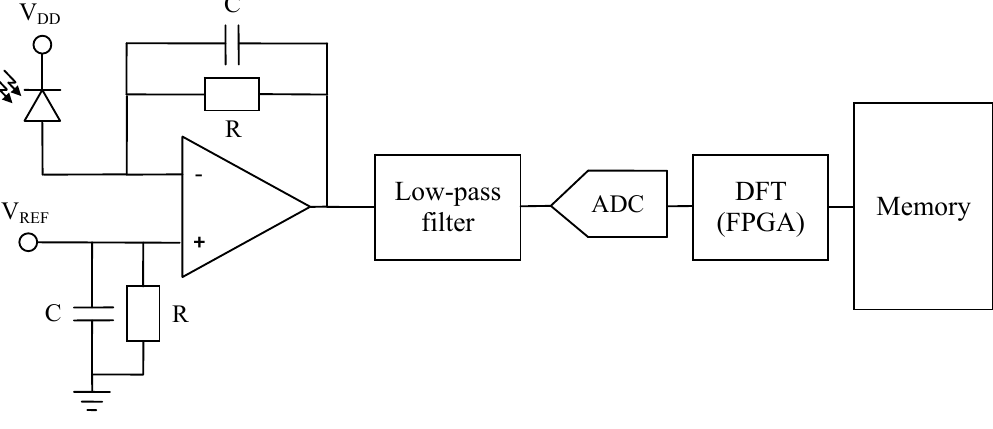
Figure 4. Electronic set-up for the acquisition of the optical current sensor